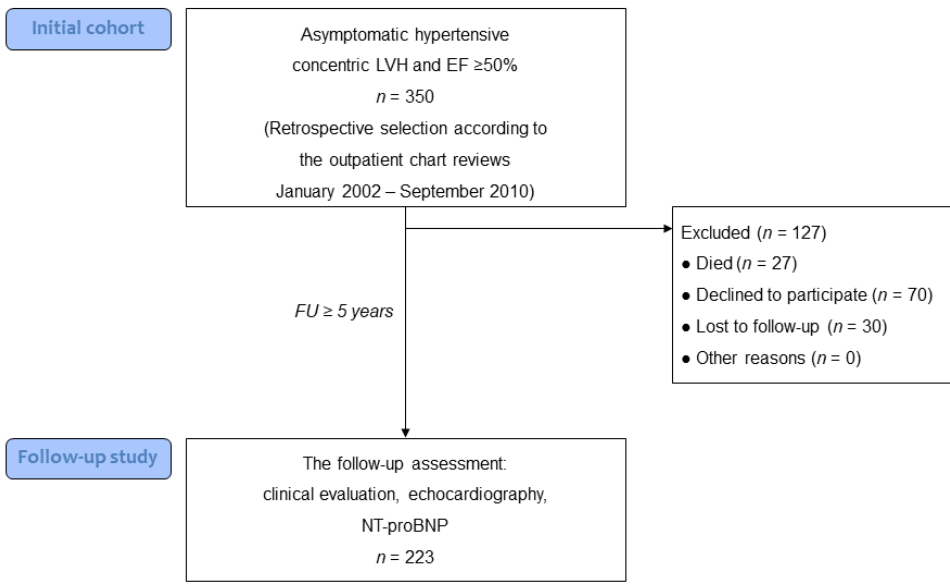
Figure 1. Flow chart of patient enrolment. EF indicates ejection fraction; FU, follow-up; LVH, left ventricular